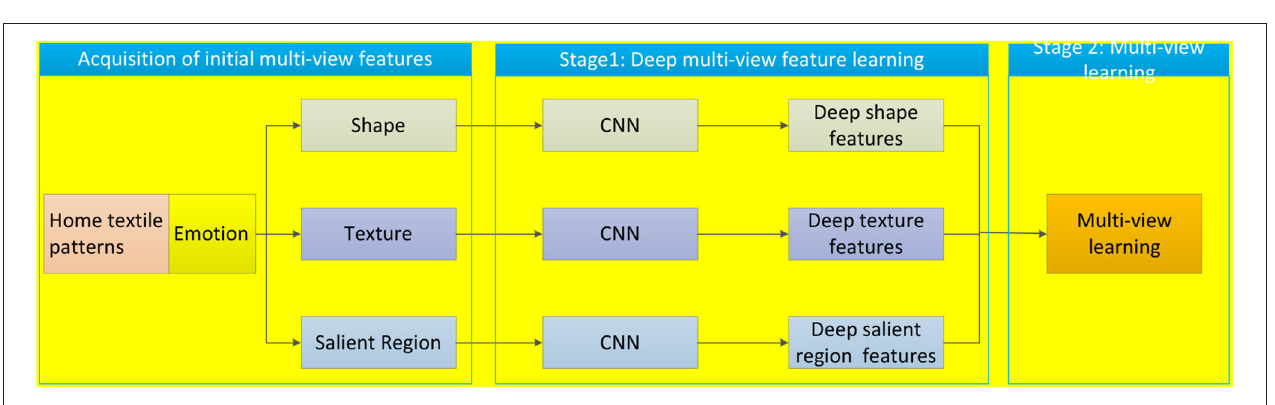
FIGURE 1 | An example of high and low aesthetic home textile patterns.